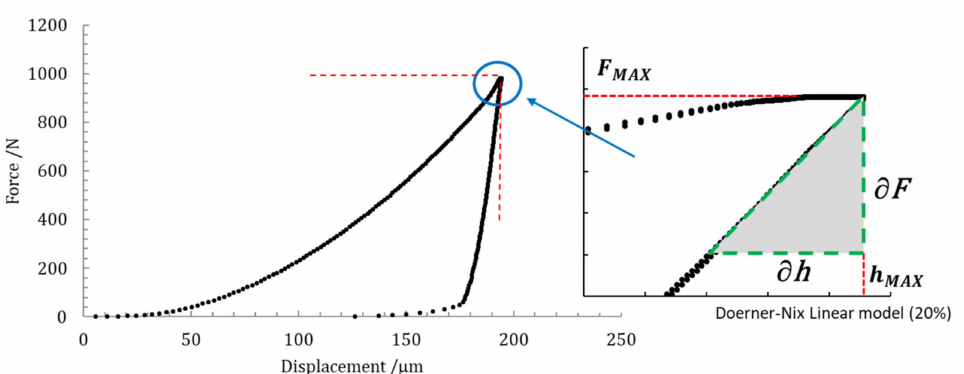
Figure 2. Loading–unloading paths of the indentation curve, expressed as a function of applied force and displacement, with quantities used for the determination of contact stiffness S .